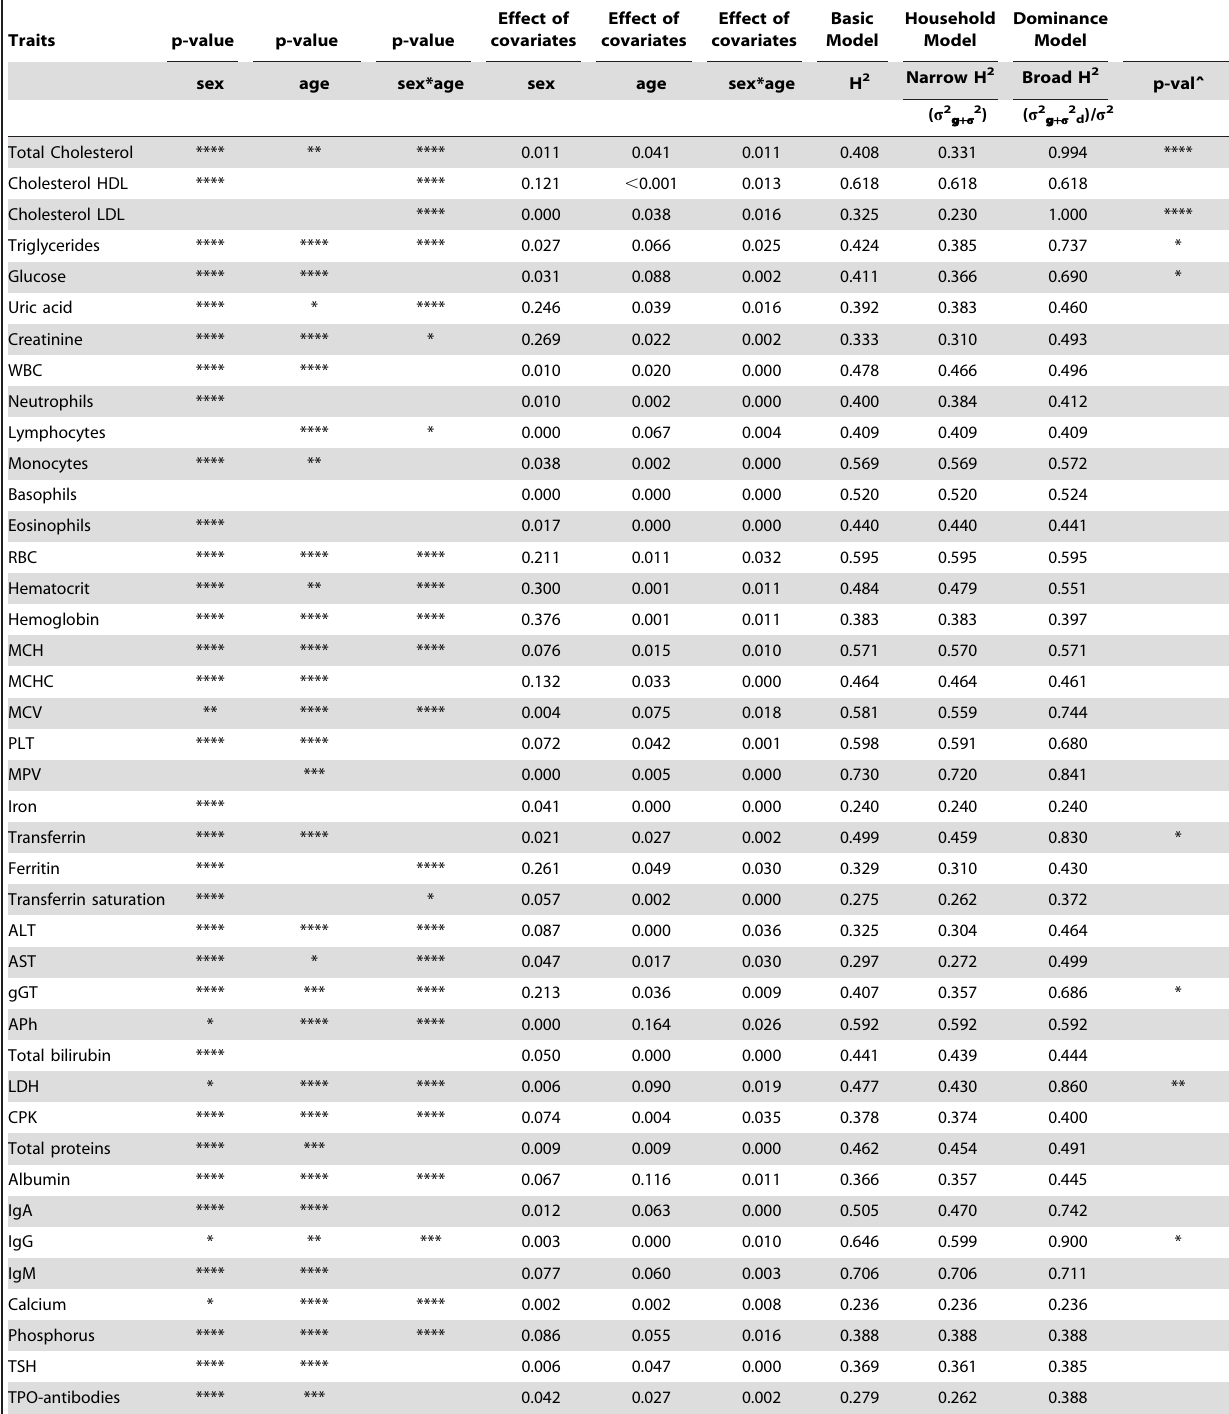
Table 1. Heritability of blood measures.